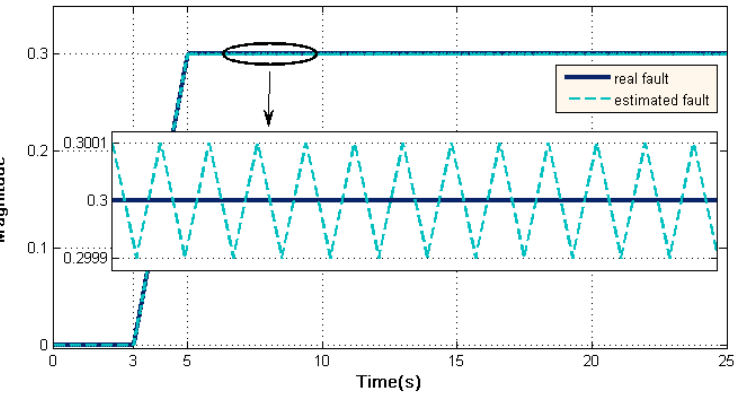
Figure 5. Diagnosis of inter-turn short circuit fault in the electrical machine of TWT: 30% of a -phase turns are defected at t = 3